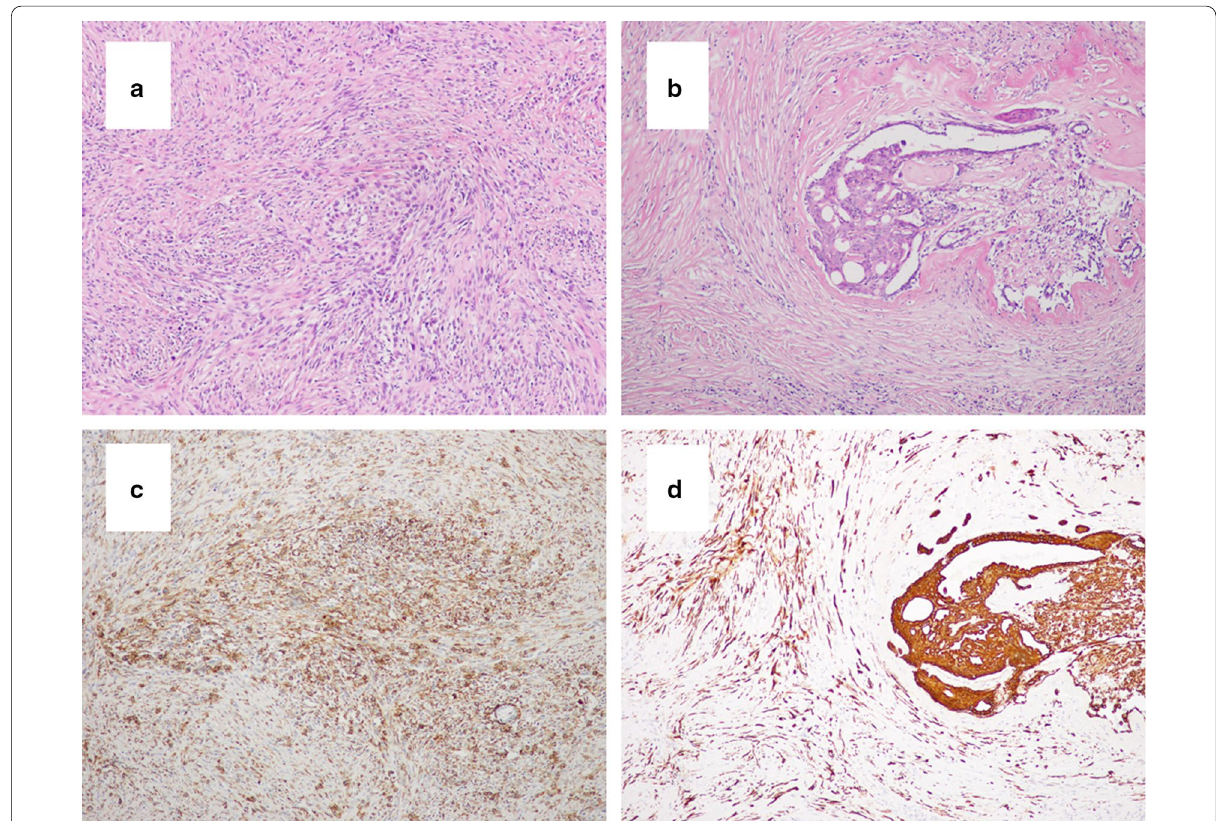
Fig. 5 Immunohistological findings of the lumpectomy specimen. a Low-grade and slightly atypical spindle cells and partly atypical spindle cell carcinoma were observed